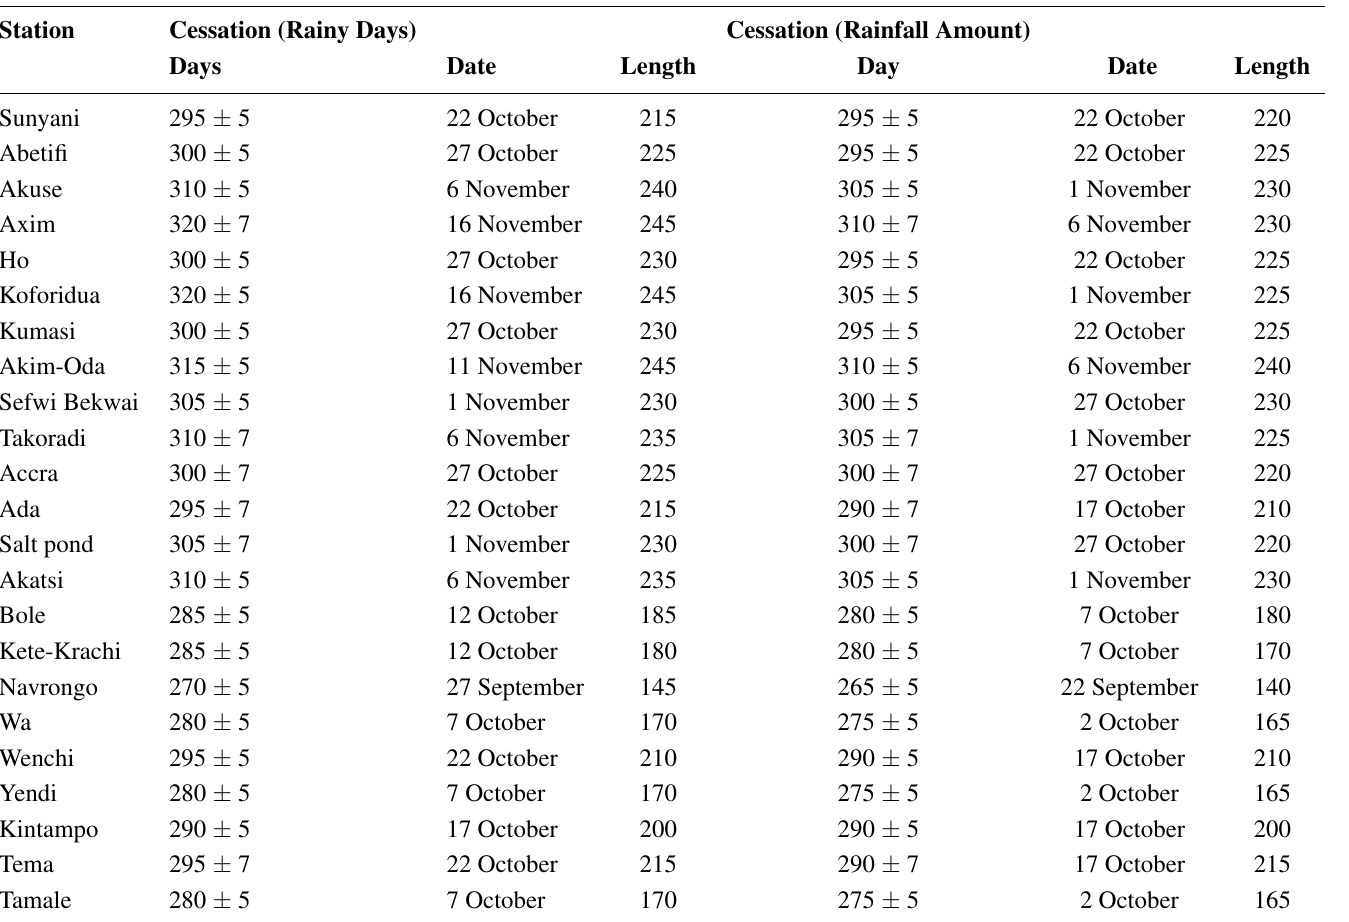
Table 2. Summary of the cessation days/dates and the length of the rainy season for the GMet